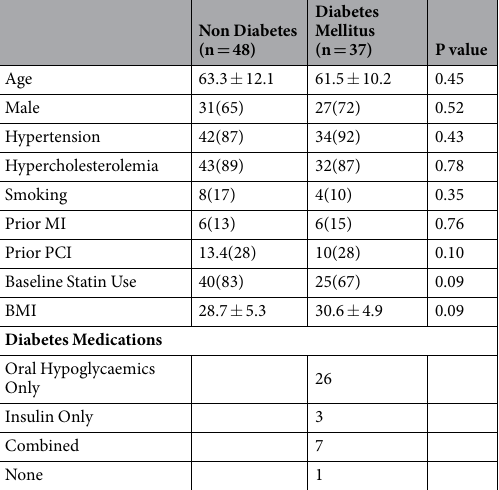
Table 1. Baseline Demographics. Values are mean ± SD or n (%) MI- Myocardial infarction, PCI- Percutaneous coronary intervention, BMI- Body mass